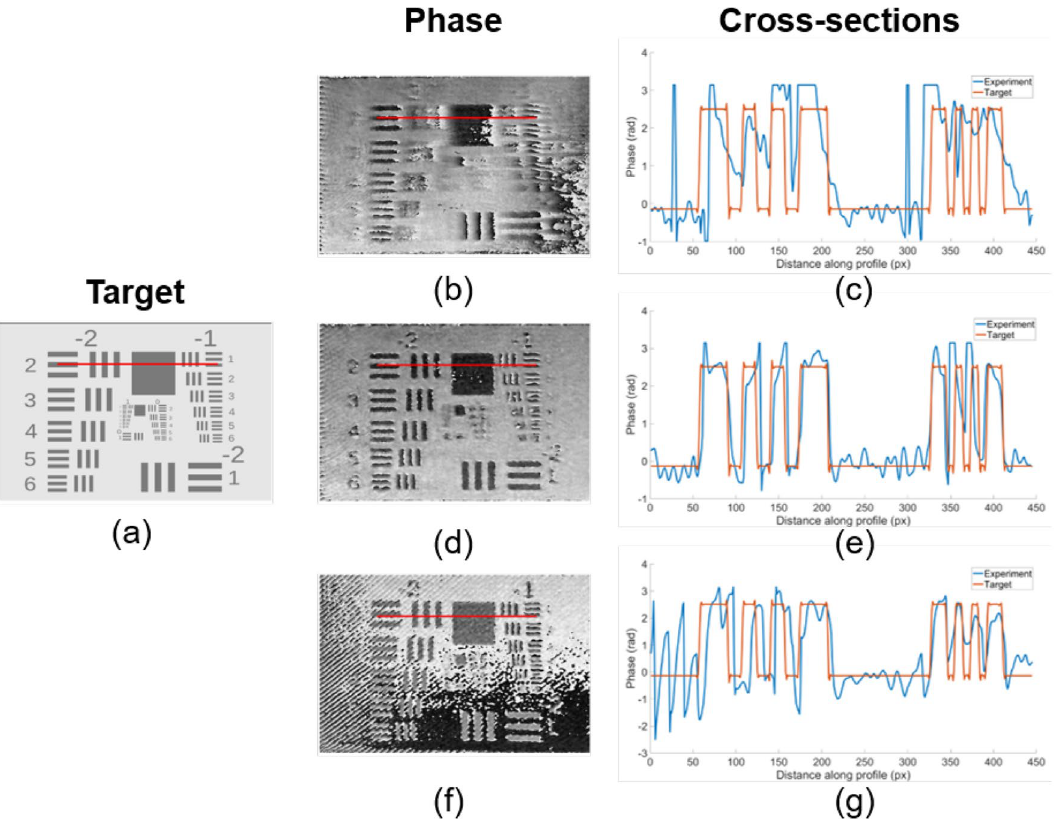
Figure 6. The results of phase distributions reconstruction with different filtering aperture sizes. ( a ) Target phase distribution; ( b , d , f ) reconstructed phase distributions with aperture size 1.5 mm, 2.25 mm and 3.0 mm, respectively, are shown in the first column. The red lines indicate the coordinates of cross-sections; the cross- sections ( c , e , g ) of the reconstructed phase distributions and target distribution are shown in the second